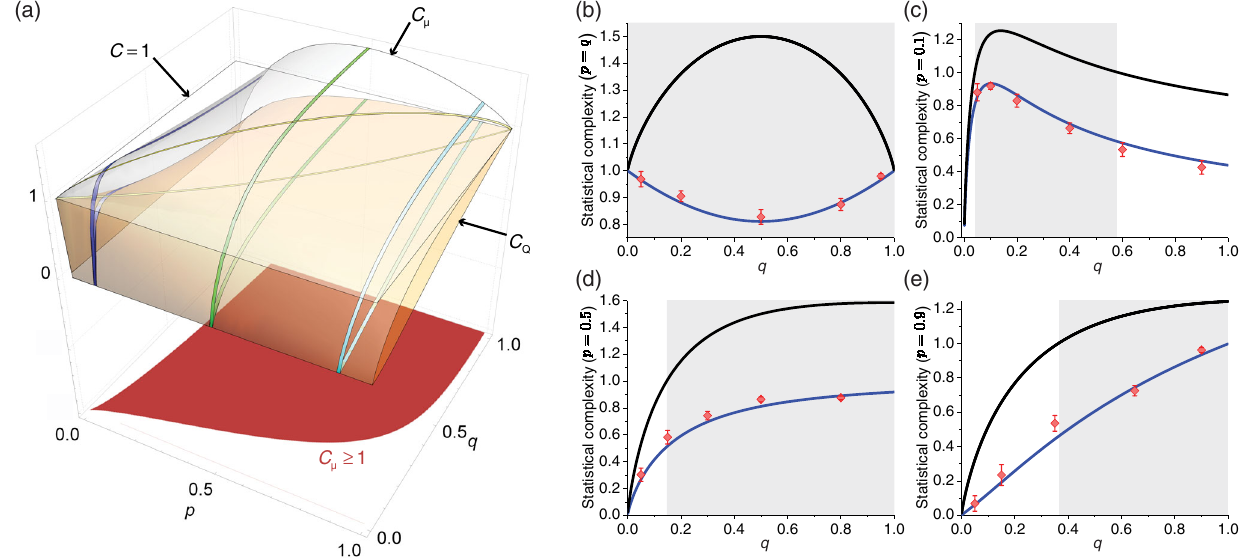
FIG. 4. Statistical complexity of the classical and quantum simulators. (a) The theoretically calculated statistical complexity. The pale grey surface depicts C μ , while the pale orange surface shows C Q . The transparent plane marks the value C ¼ 1 . The yellow, purple, green, and cyan cuts illustrate specific cross sections, which are experimentally probed and shown in panels (b), (c), (d), and (e), respectively. The red projection on the floor illustrates the ð p; q Þ values for which C μ ≥ 1 . (b) – (e) The quantum simulator is used to investigate several sets of processes with different values of p and q . The entropy of the reconstructed stationary states (see Appendix C) determines the quantum statistical complexity (red dots). The black and blue curves represent the theoretical C μ and C Q , respectively. The plots demonstrate a considerable memory advantage for the i.i.d. case. Furthermore, the grey shaded areas mark processes where the complexity C μ of the classical simulator exceeds one bit, while the quantum simulation runs with only one memory qubit. Uncertainties are estimated from the Poissonian distribution of photon